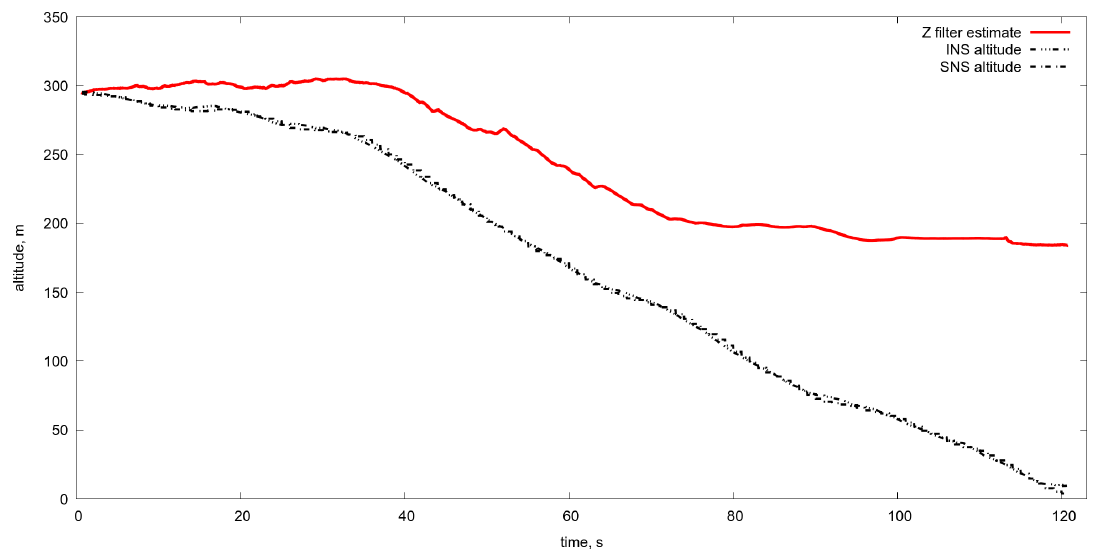
Figure 7. Estimated altitude with the aid of images registered by optoelectronic system without averaging in comparison with the real one given by inertial navigation system with satellite measurements. One can see that estimation on the basis of the Lucas-Kanade algorithm without averaging does not work in the entire range of the altitudes less than 300